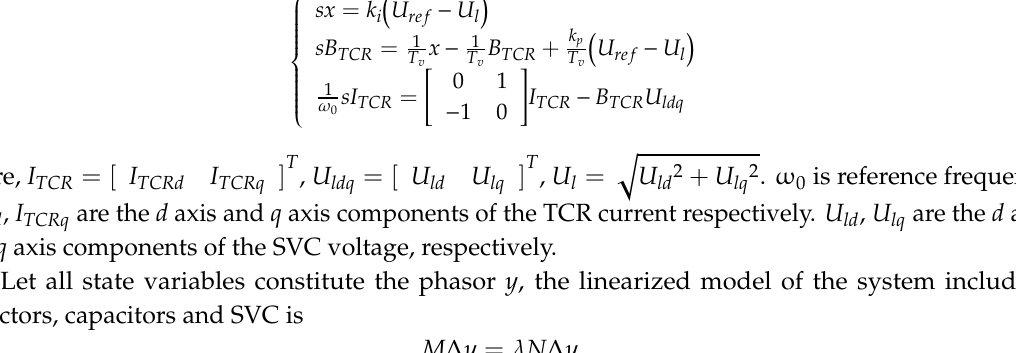
Figure 8. Variation trend of eigenvalues of the main electromagnetic oscillation mode with capacities of SVCs (1000 km transmission line). 3.4. Sensitivity of SVC Control Parameters to Electromagnetic Oscillation The variation trend of eigenvalues of the electromagnetic oscillation mode with SVC PI parameters is shown in Figure 9. As shown in Figure 9a, when ω is less than 1570 rad/s ( f < 250 Hz), with the increase of K p , the eigenvalues of the electromagnetic mode move to the right side of the complex plane. K p has the greatest influence on the oscillation mode when ω is less than 314 rad/s ( f < 50 Hz). When ω is greater than 1570 rad/s ( f > 250 Hz), K p has almost no effect on the electromagnetic oscillation mode. As shown in Figure 9b, when ω is greater than 314 rad/s ( f > 50 Hz), K i has almost no effect on electromagnetic oscillation mode. When ω is less than 314 rad/s ( f < 50 Hz), with the increase of K i , the eigenvalues of the electromagnetic mode move to the right side of the complex plane. When ω equals 314 rad/s ( f = 50 Hz), the PI parameters of SVC has no effect on the oscillation mode.